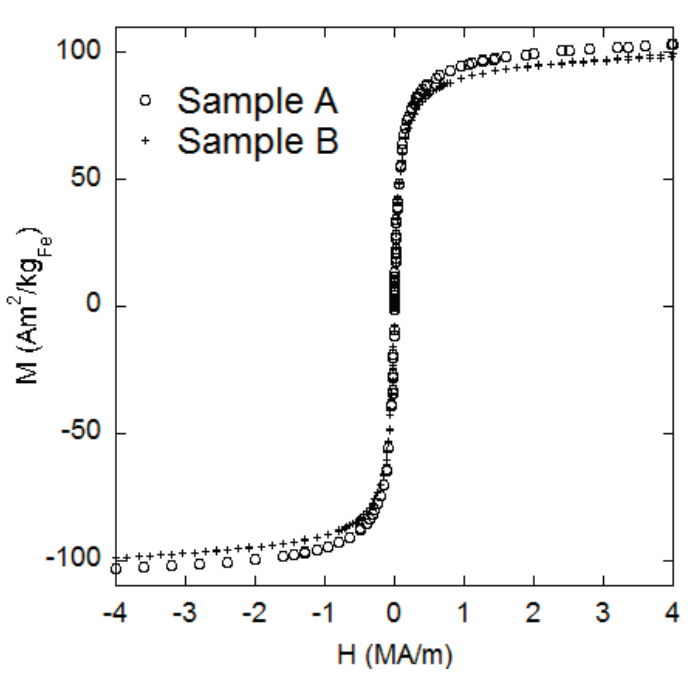
Figure 6. DC magnetization versus applied field for samples A and